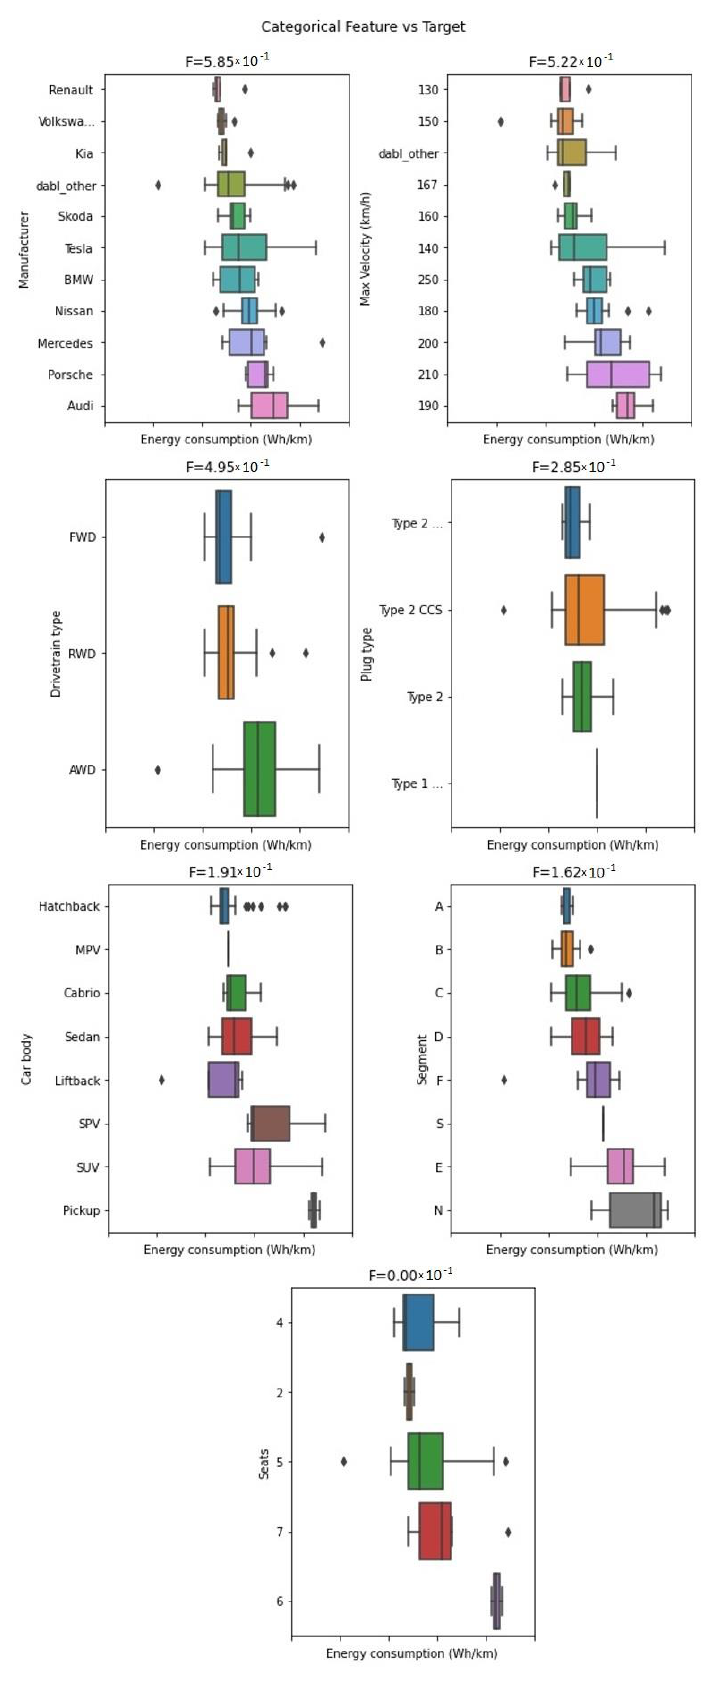
Figure 7. Categorical feature vs. energy consumption as a